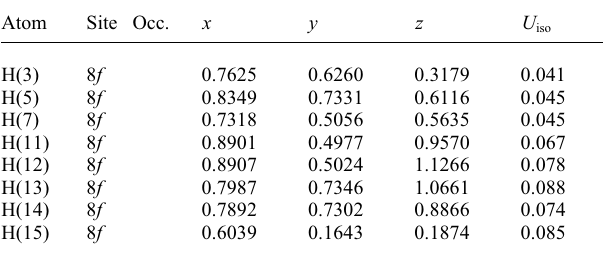
Table 2. Atomic coordinates and displacement parameters (in Å 2 )